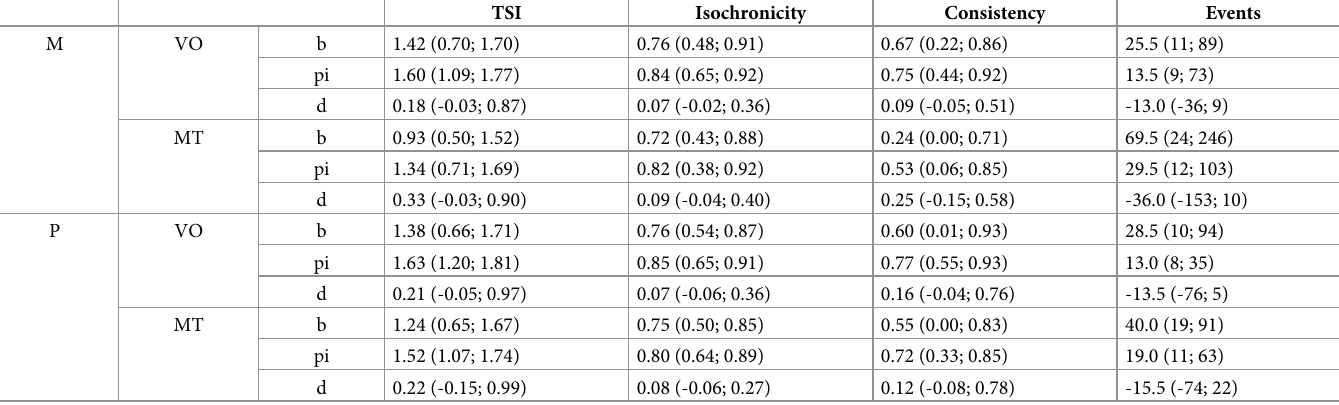
Table 3. Parameters of systematics obtained from video observation (VO) and motion tracking (MT) for manual (M) and powered (P) toothbrushing; b = baseline, pi = post instruction, d = difference post instruction–baseline.